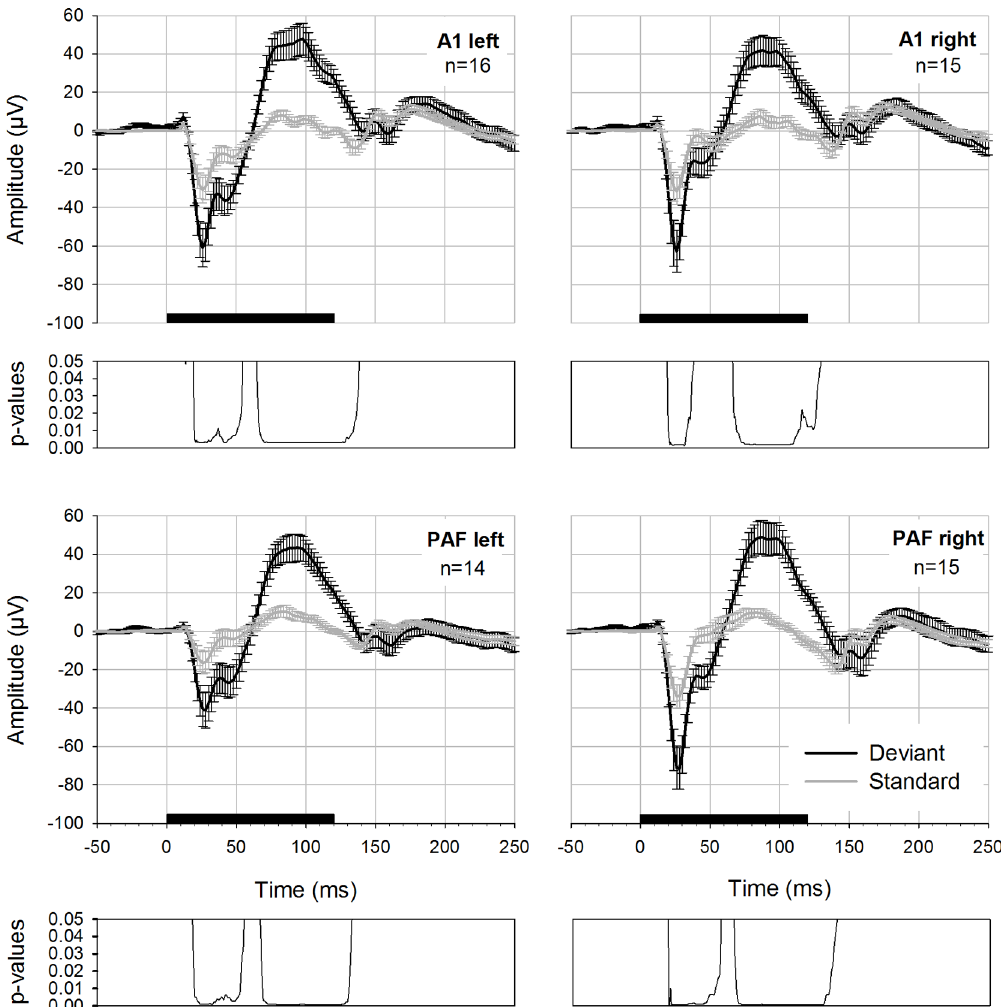
Figure 3. AEPs to deviant and standard stimuli elicited with a deviant probability of 0.1. Deviant (black curve) and standard potential (grey curve) with errorbars (standard error of the mean) displayed for four electrodes. Black bar on the x-axis shows the stimulus duration. Below each graph FDR-corrected p-values are shown.